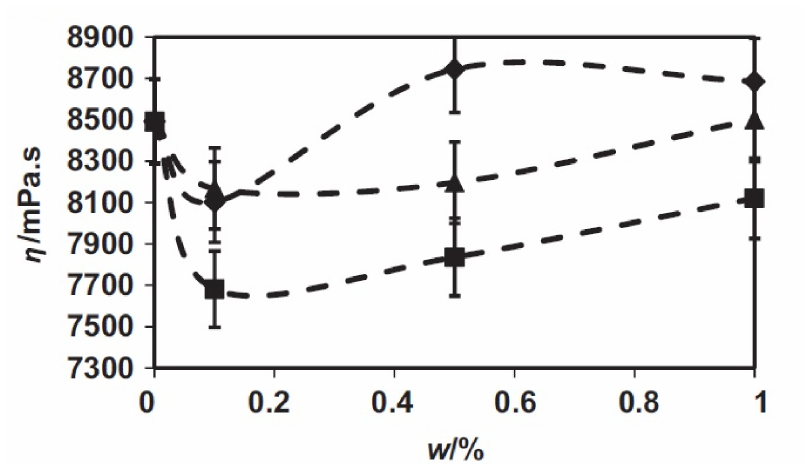
Figure 40. The effect of different metal species on the viscosity of a heavy oil at a fixed temperature (25 °C) as a function of the nanocatalyst concentration for: (cid:7) iron; (cid:4) copper; and (cid:78) iron oxide (III). Figure reproduced from Ref. [170].